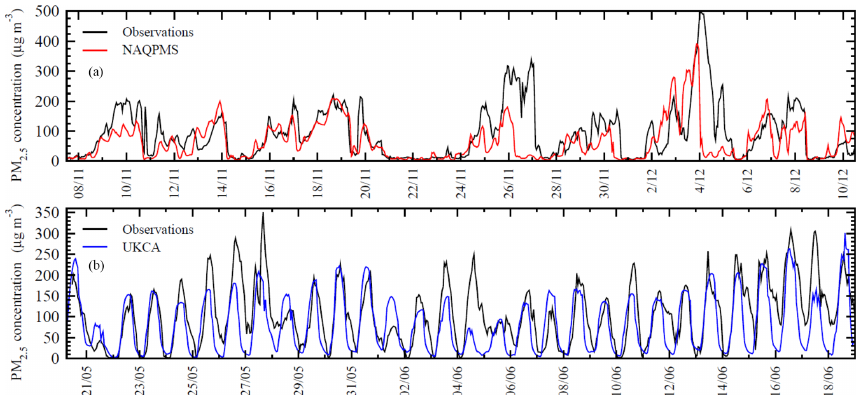
Figure 11. Comparison of observed (at IAP) and modelled pollutant concentrations showing (a) PM 2 . 5 concentrations during the winter campaign compared with NAQPMS simulations and (b) O 3 mixing ratios in summer compared with UKCA simulations.